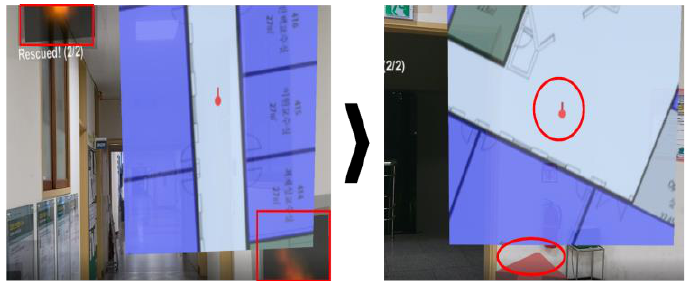
Figure 15. Movement toward another exit.